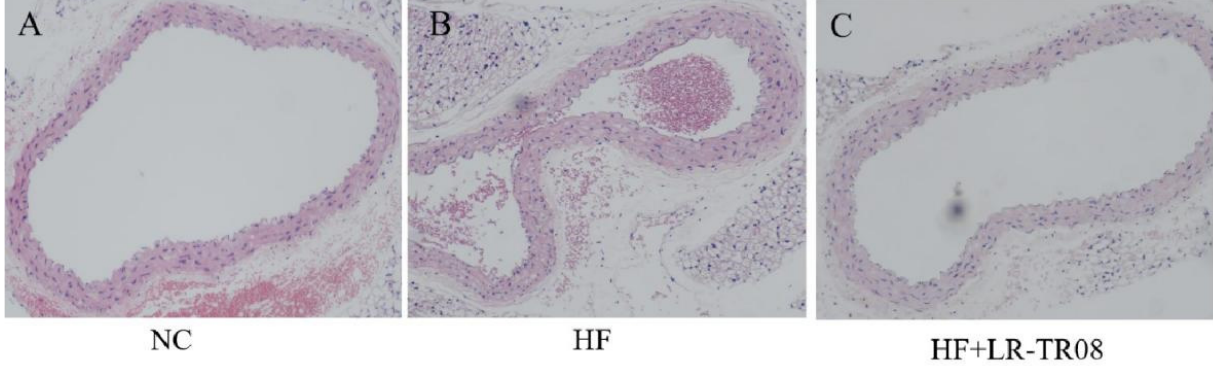
Figure 2. HE staining of mouse aortic tissue. The fixed blood vessels were embedded in wax and dehydrated for cut preparation (6 μ m thickness). Normal control group: NC, high − fat diet group: HF, and high − fat diet + L. rhamnosus TR08 strain group: HF+LR − TR08. 2.3. L. rhamnosus TR08 Influenced the Intestinal Microbiota and SCFAs Production in Hyper ‐ lipidemia Mice